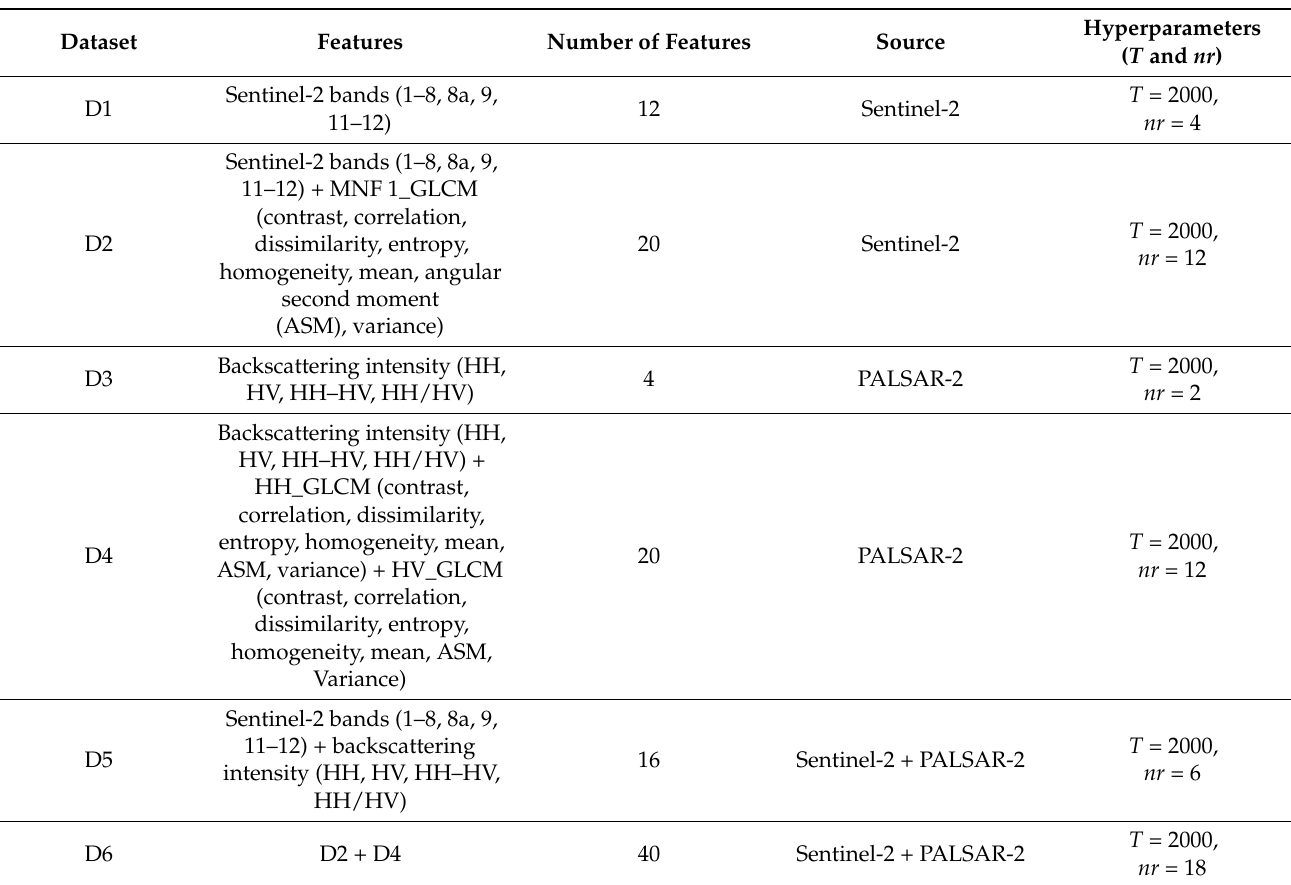
Table 3. Six datasets of different input features for LCZ classification and hyperparameters used for RF classifiers ( T : the number of trees; nr : the number of features randomly selected at each